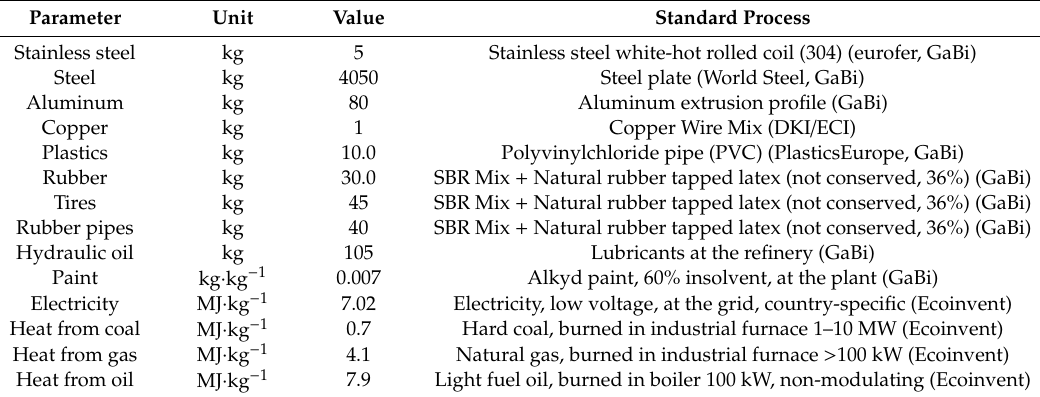
Table 3. Material and energy balance of the chipper used in the considered